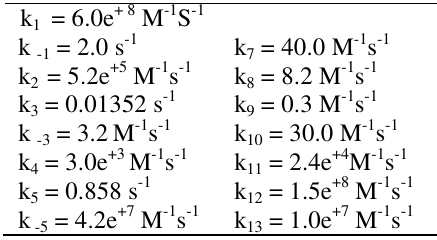
Table 2. Rate constants of 15 reaction